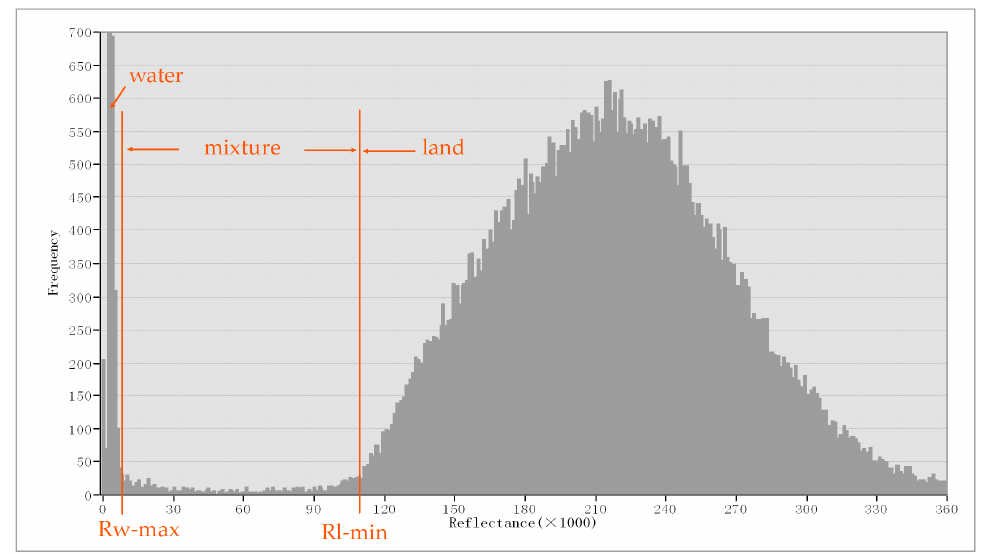
Figure 3. An example of the two-peak histogram of the NPP–VIIRS short-wave infrared (SWIR) band, and the demonstration of feasible ranges.